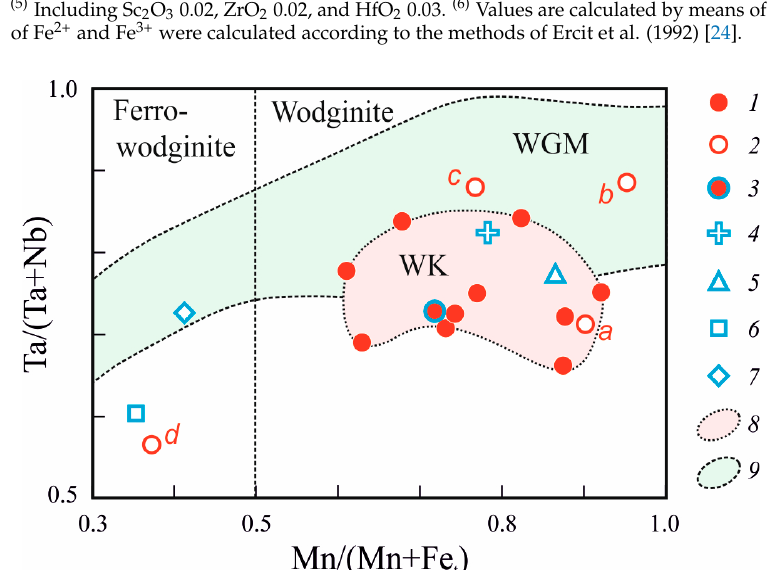
Figure 3. Chemical compositions of tungsten-bearing wodginite in Li-F granites from the Kester deposit and from other deposits and wodginite-group minerals in the world plotted in the columbite quadrilateral (atomic proportions): 1—Tungsten-bearing wodginite from the Kester deposit. 2—Tungsten-bearing wodginite from other deposits: a —Dajishan, China (average of 2 samples) [12]; b —Keivy, Kola Peninsula [3]; c —Pendalras, India (average of 12 samples) [20]; d — Songshugang, China (average of 3 samples) [11]. 3—“Wolframowodginite” (average of 5 samples) [19]. 4—Wodginite (70 samples) [5,6,10–13,15]. 5—Titanowodginite (7 samples) [5,6,29]. 6— Ferrowodginite (6 samples) [8,11]. 7—Ferrotitanowodginite (2 samples) [14]. 8—The fields of wodginite from the Kester deposit (WK). 9—The fields of wodginite-group minerals (WGMs) [30]. Compositions are shown in Table 1. Figure 4. Compositions of tungsten-bearing wodginite in Li-F granites from the Kester deposit and from other deposits and wodginite-group minerals in the world in the quadrilateral of wodginite classification Mn/ Σ A versus W/ Σ C (atomic proportions). Σ A , Σ C —the sums of cations in positions A (Mn 2+ , Fe 2+ , Li, Ca) and C ( B Ta, Nb, W). For symbols, see Figure 3. The closest analog of wodginite from Yakutia is wodginite in LFGs from the large tungsten Dajishan deposit in Southeast China [12]. Characteristic features of wodginite from LFGs, such as high contents of Nb 2 O 5 and WO 3 , have a stronger manifestation in wodginite from the Songshugang Nb-Ta-W-Sn deposit in China [11] (Table 1). The wodginite under consideration is close in composition to titanowodginite (Figures 3 and 4).